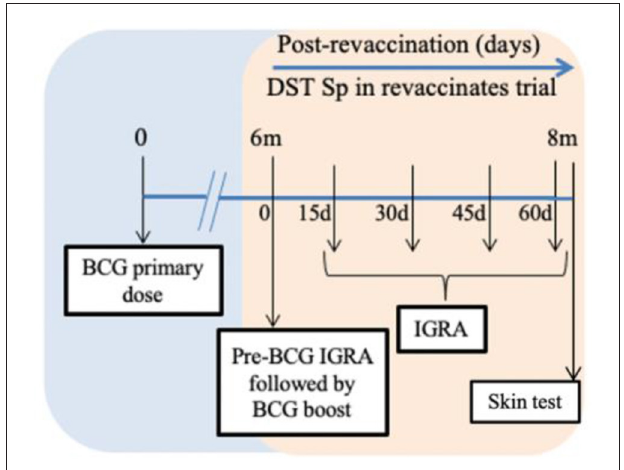
FIGURE 1 | Timeline chart. Calves received the first Bacillus Calmette–Guérin (BCG) dose on day 0 of the previous trial (blue section) ( 20). The orange section represents the current trial. BCG revaccination was performed after 6 months of the first dose (day 0 of current trial). Blood was collected for interferon-gamma release assay (IGRA) just prior to revaccination with BCG and on days 15, 30, 45, and 60 post revaccination. Skin test was conducted on day 61 post-revaccination. The duration of the current trial from revaccination to skin test is 2